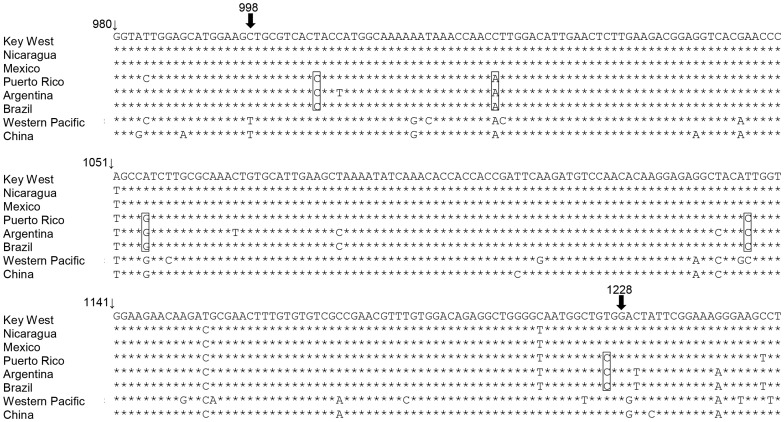
Nucleotide alignment of the recombination region.The breakpoints in the recombination region between KW and PR are indicated with black arrows. The stars represent identical nucleotides between sequences, nucleotides of PR conserved with BR and AG are boxed.